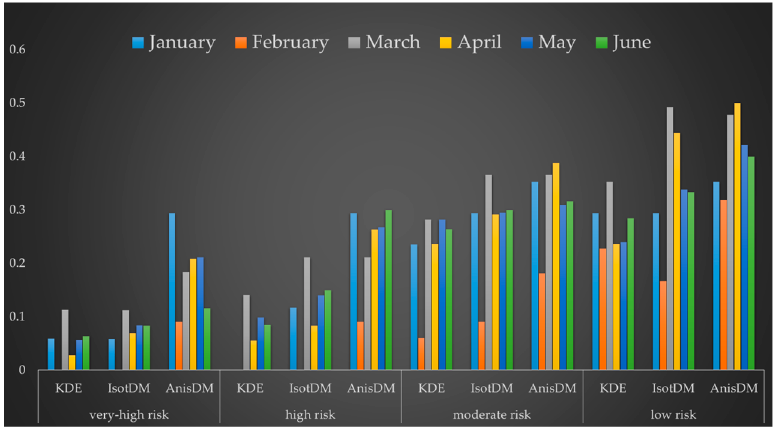
Figure 12. Monthly hit rate of IsotDM and AnisDM.